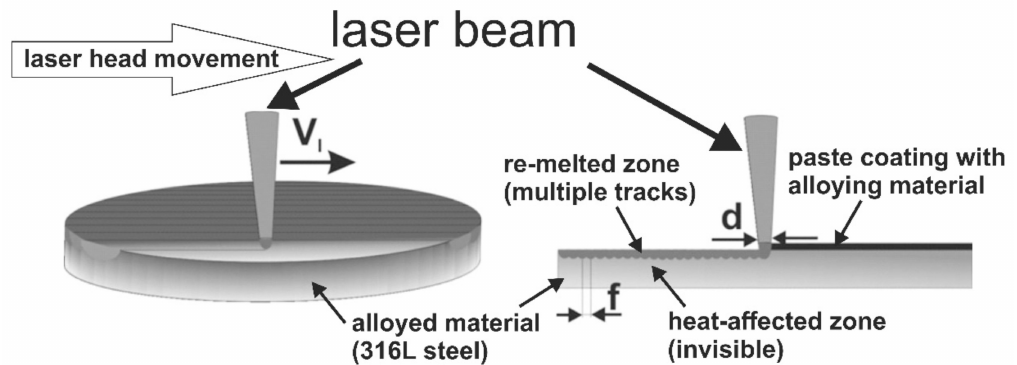
Figure 1. The technique of the multiple laser tracks’ formation along the flat surface of disc-shaped specimens; d —laser beam diameter; v l —scanning rate; f —distance from track to